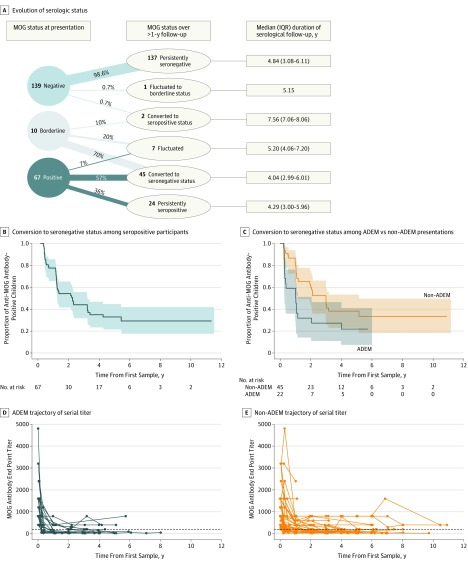
Myelin Oligodendrocyte Glycoprotein (MOG) Results on Serial SamplesA, Evolution of serologic status in participants with follow-up greater than 1 year. Only 2 of 139 participants who were negative for anti-MOG antibodies at presentation changed serological status in subsequent examinations: 1 participant became seropositive at 3 months and was persistently positive for the subsequent 8 years and 1 had an isolated finding of a borderline result at 2 years from onset. Of the 10 participants with borderline results at onset, 7 became seronegative, 2 fluctuated between negative and borderline status and 1 became seropositive in the last follow-up sample (7 years from onset; titer, 1:200). B, Kaplan-Meier curve for the time to conversion to seronegative status in all participants who were positive for anti-MOG antibodies at time of presentation. The shaded areas indicate 95% CIs. C, Kaplan-Meier curves in participants with acute disseminated encephalomyelitis (ADEM) vs non-ADEM presentations. Participants with ADEM had a considerably shorter time to seroconversion than participants without ADEM. The shaded areas indicate 95% CIs. D and E, Trajectory of serial MOG titers of anti-MOG antibody–positive participants with ADEM at onset (D) and without ADEM at onset (E). The data points indicate the titers measured at each serological evaluation.